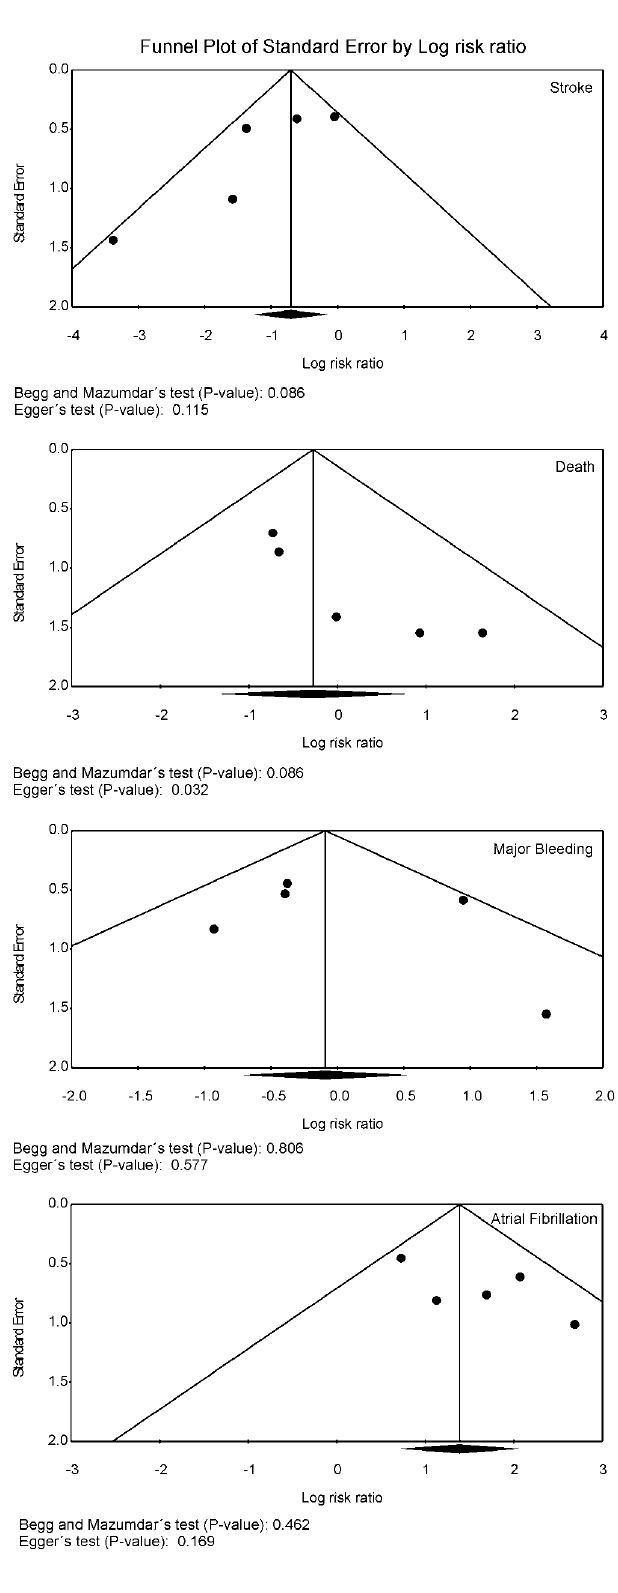
Fig. 4 – Publication bias analysis of clinical outcomes by funnel plot